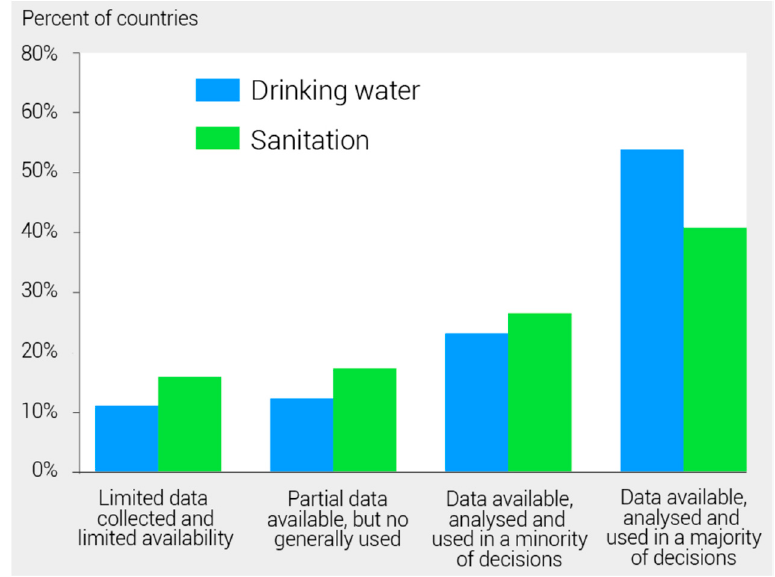
Figure 3. Data collected and used to inform decisions on resource allocation (65 countries). Source: [19].